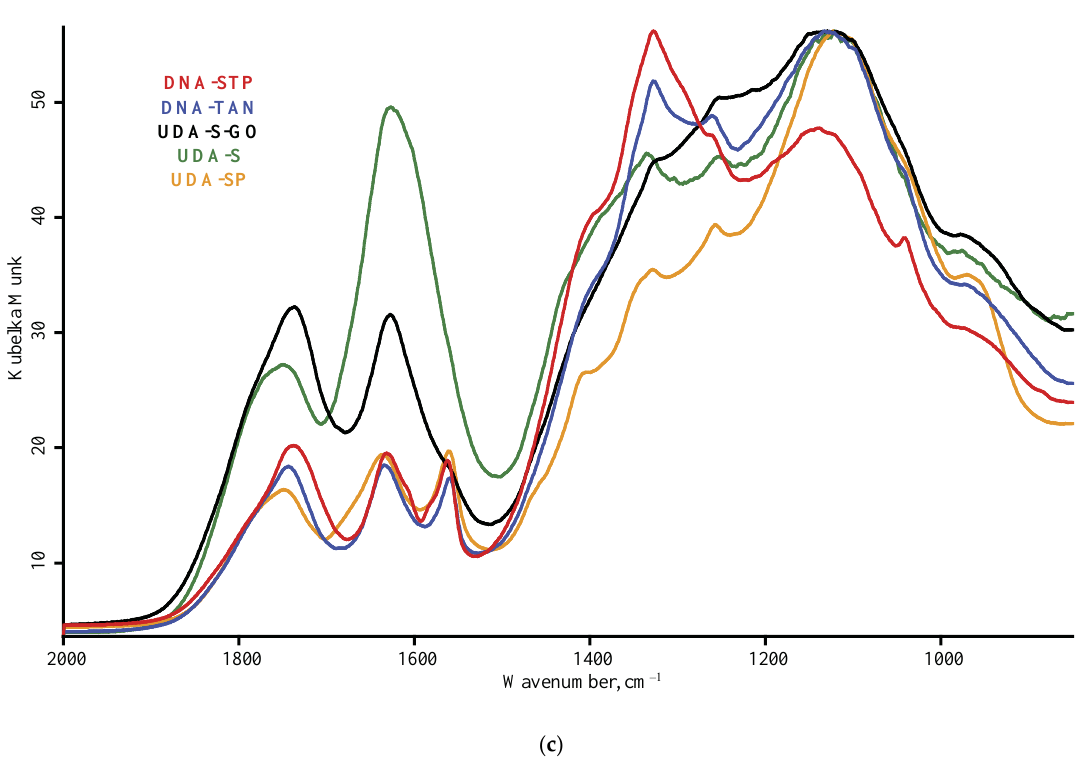
Figure 2. Diffuse reflectance mode, LN-MCT photovoltaic detector; nanodiamond brands: red, DNA-STP; blue, DNA-TAN; black, UDA-S-GO; green, UDA-S; orange, UDA-SP; ( a ) 6000–4000 cm −1 , ( b ) 4000–2000 cm −1 ( c ) 2000–800 cm −1 range. Spectra are smoothed (13 points) and normalized to maximize each spectrum.